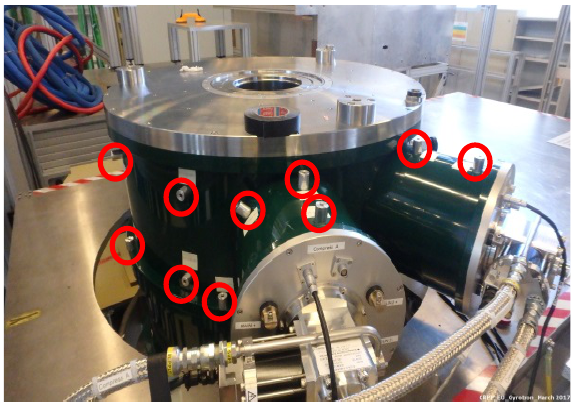
Fig. 8. Metrology network (laser tracker targets depicted in the red circles) as set on the SC magnet at the SPC tests stand (reference place set on the top plate of the magnet).